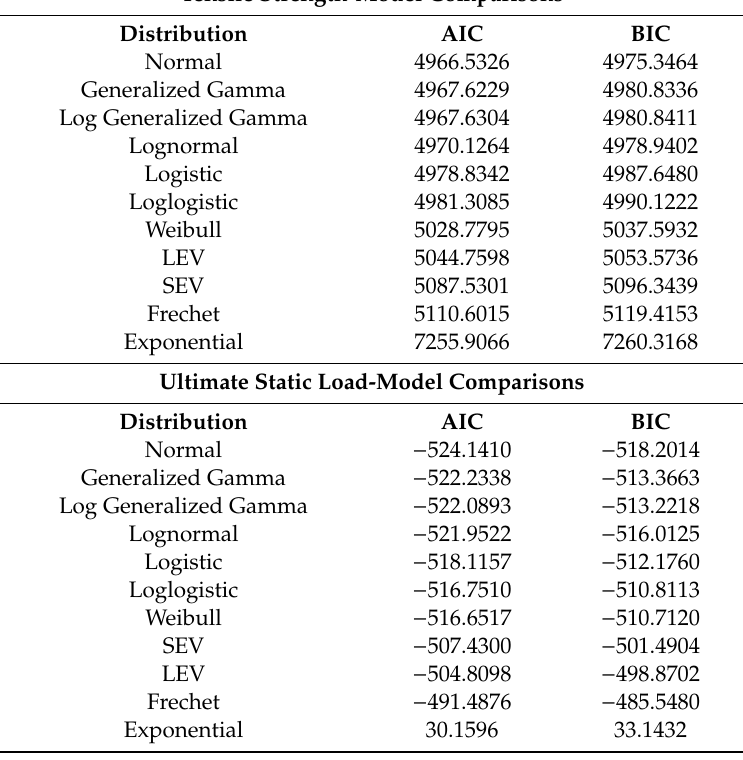
Table 1. Akaike Information Criteria (AIC) and Bayesian Information Criteria (BIC) statistics for tensile strength pdfs of medium density fiberboard (MDF) and ultimate static load of oriented strand board